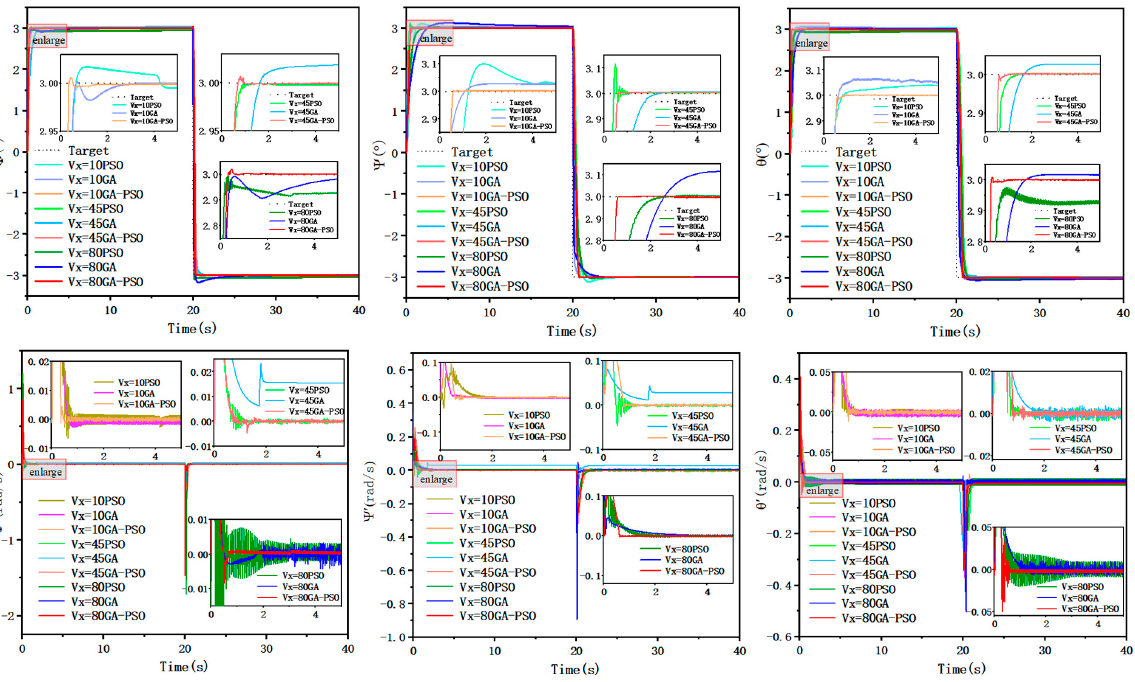
Figure 10. Attitude response with different forward speeds.